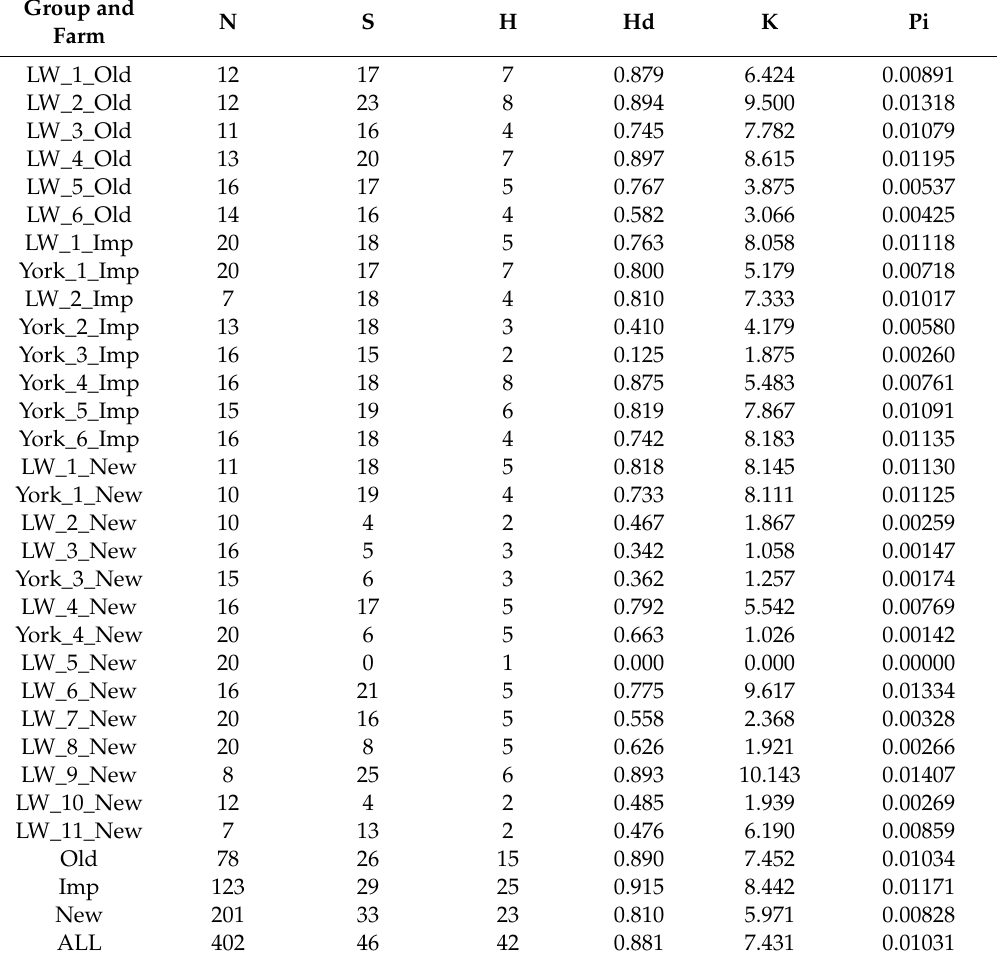
Table 2. Parameters of genetic diversity of Large White and Yorkshire pig populations in Russia. Group and Farm